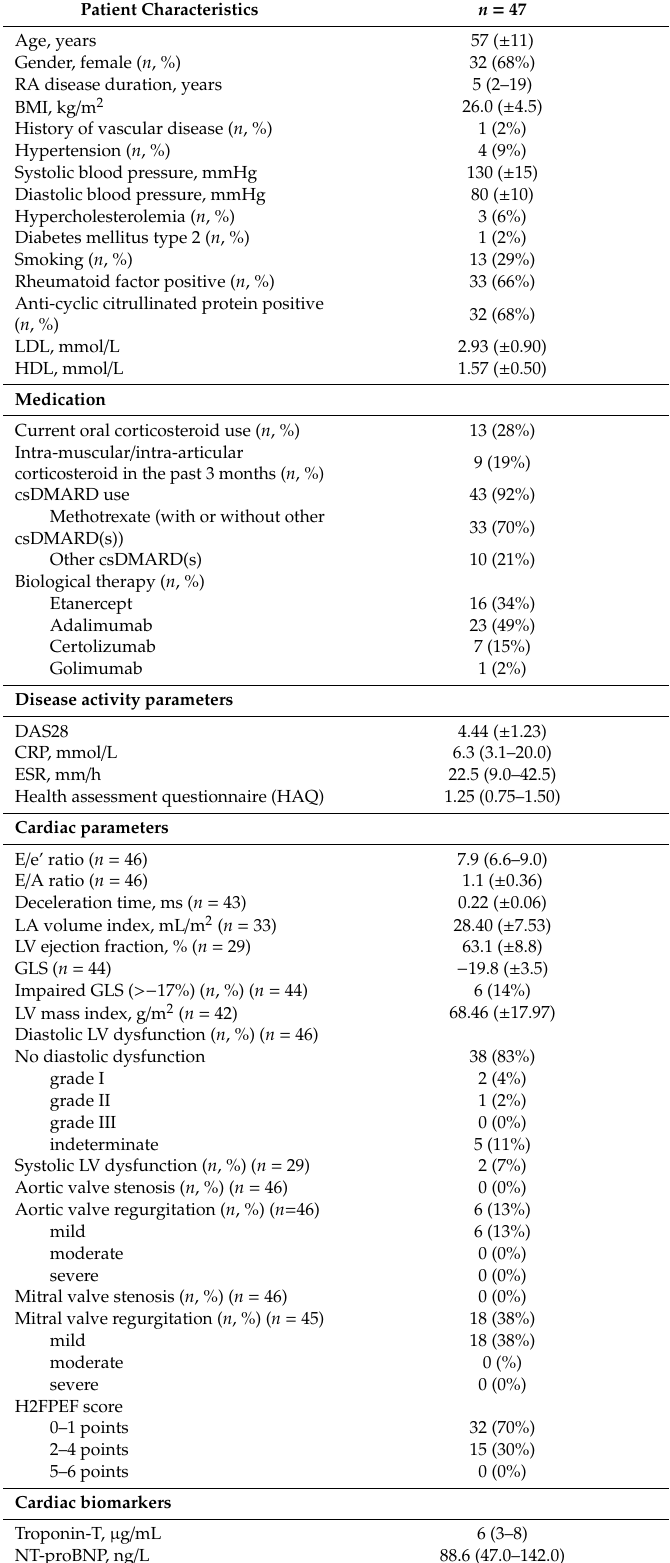
Table 1. Baseline